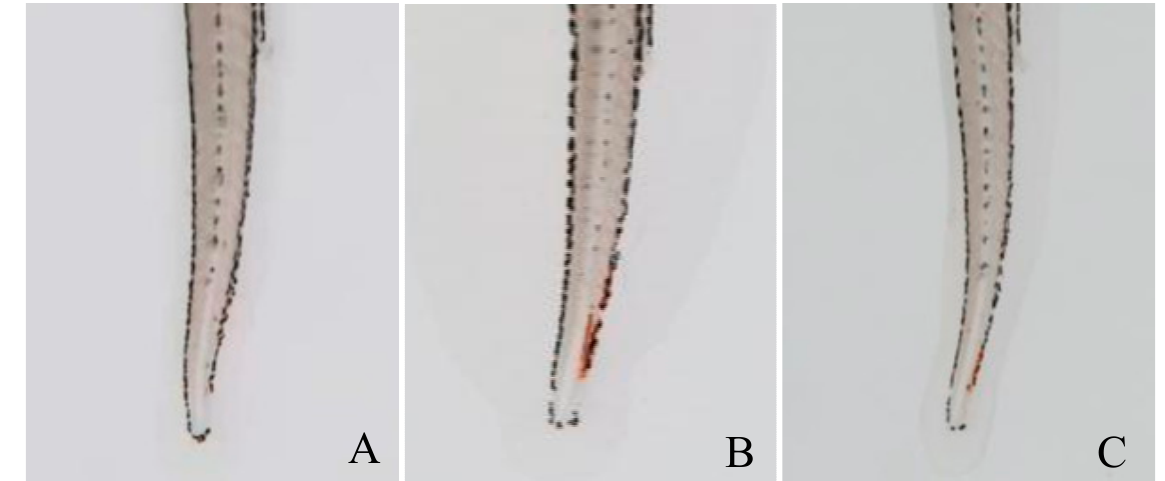
Figure 3. The staining of erythrocytes in the tail vein of zebrafish in ( A ) the normal group, ( B ) the model group and ( C ) the treatment group. Table 2. The staining intensity of tail vein erythrocytes (Mean ± SD, n = 18).